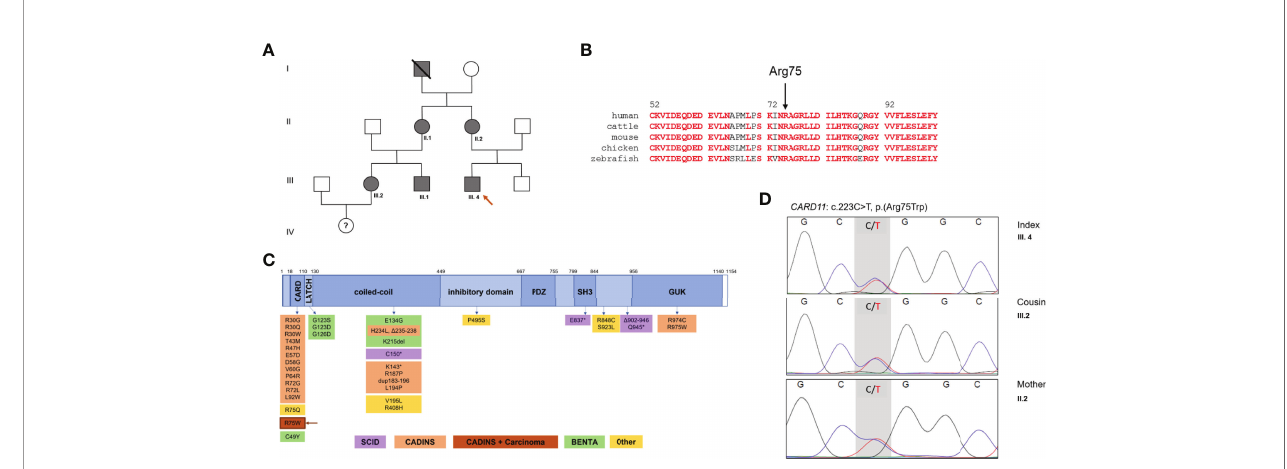
FIGURE 1 | Family pedigree and CARD11 domains in health and diseases. (A) Family pedigree. (B) Multiple species alignment of CARD11 protein (AA 52-101) showing high conservation of Arg75 across species. Red: full conservation. (C) Schematic representation of CARD11, with functional domains and reported variants, including monoallelic gain-of-function (GOF) variants in BENTA, biallelic LOF variants in SCID, monoallelic DN LOF variants in CARD11-associated atopy with dominant interference of NF- k B signaling (CADINS), additionally monoallelic DN LOF variants in CADINS and carcinoma. DN, dominant negative; LOF, loss of function; SCID, severe combined immunode fi ciency, * truncating variant. (D) Sanger DNA sequencing electropherograms showing the novel heterozygote variant of the CARD11 gene in III.4, his mother II.2 and his cousin